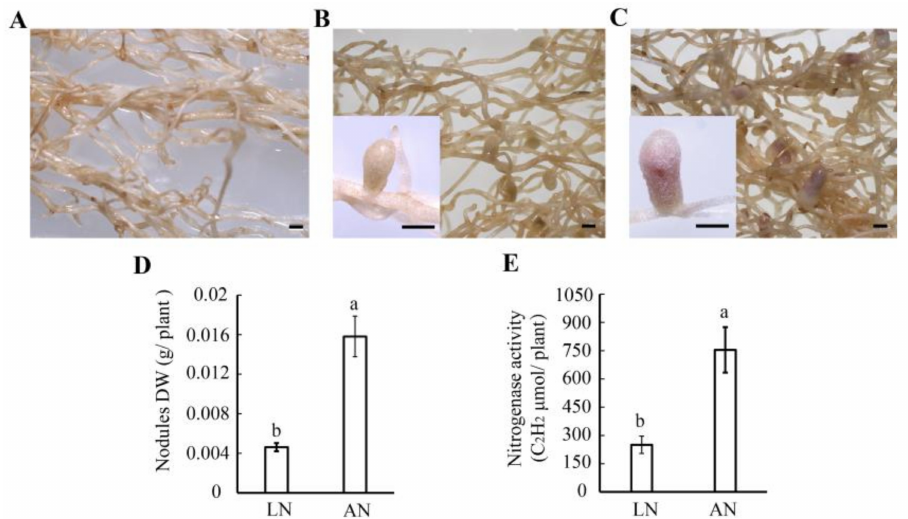
Figure 1. Analysis of rhizobia inoculation on nodule formation and nitrogenase activity in Chinese milk vetch. Roots with no nodule (NN) ( A ) were observed in 3 month old plants without inoculation and cultured in Hoagland nutrient solution. Low-activity nodules (LN) ( B ) and active nodules (AN) ( C ) were observed in 3 month old plants inoculated with rhizobia and cultured in Hoagland nutrient solution or in the low-N nutrient solution, respectively. Dry weight ( D ) and nitrogenase activity ( E ) of the nodules in 3 month old LN and AN plants were measured. Scale bars with 1 mm are presented in the figures. The data presented are means ± standard errors from 10 replicates. The same letter above the column indicates no significant difference at p <